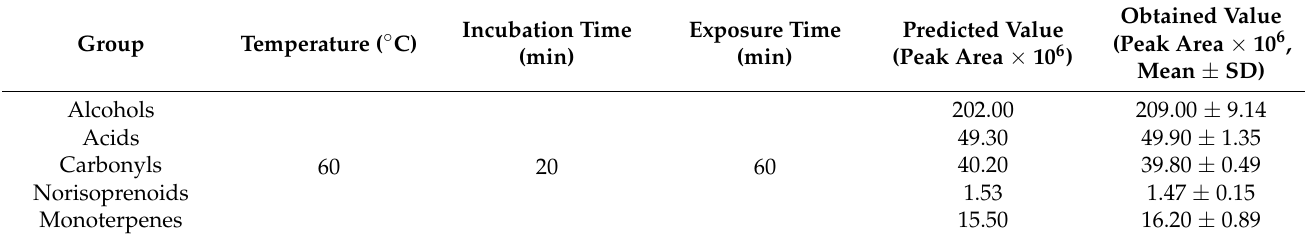
Table 4. Optimal SPME-Arrow extraction conditions, predicted and experimentally obtained values for individual groups of bound volatile compounds.